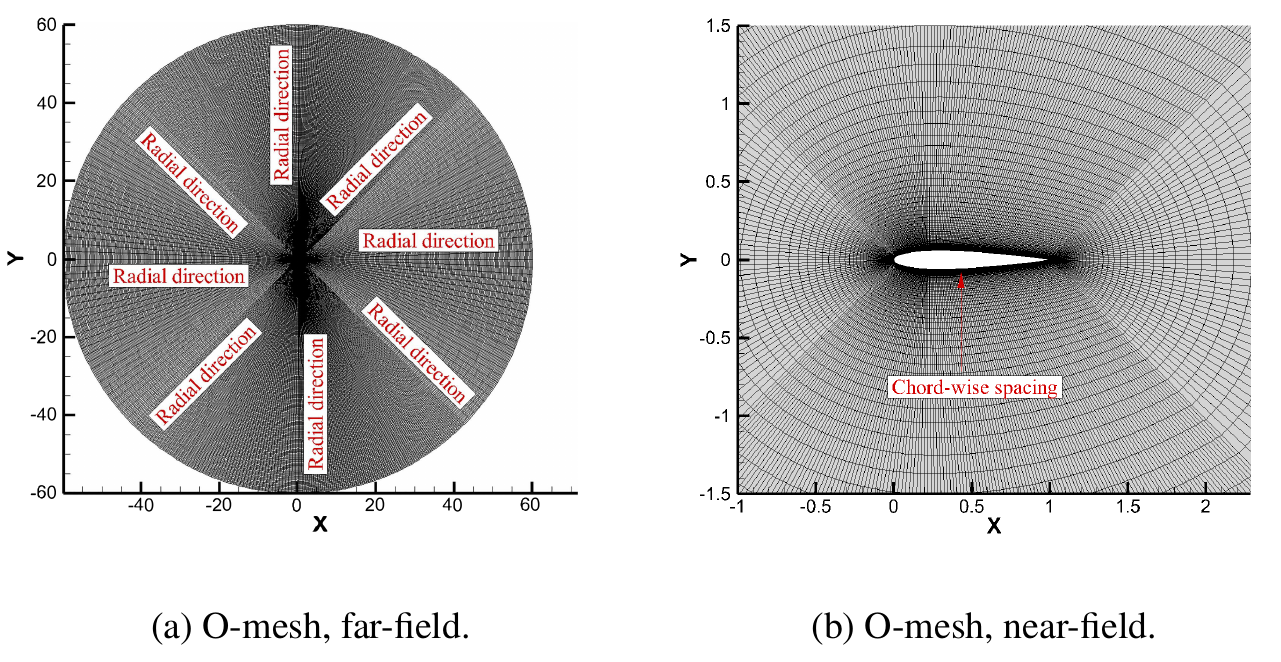
Figure 15. Node distributions for